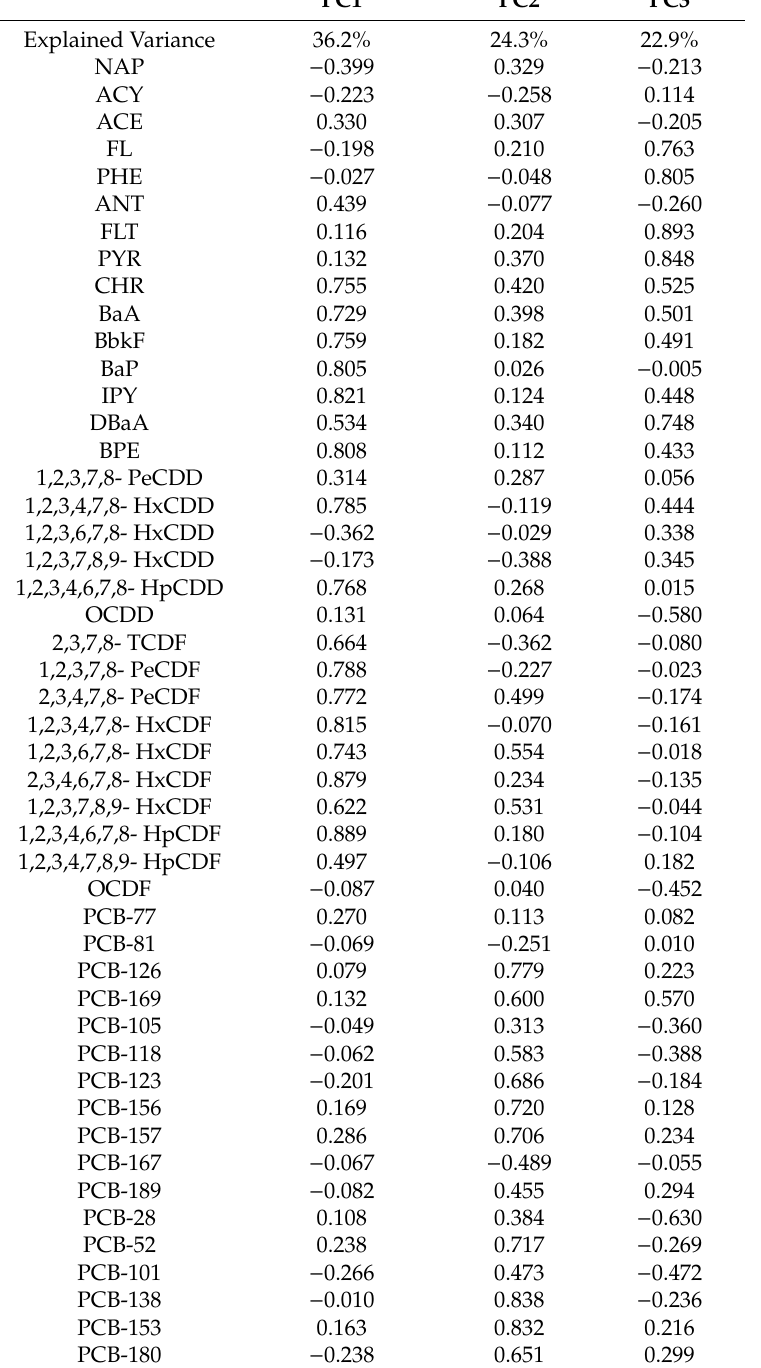
Table 7. Principal component analysis in the whole sampling